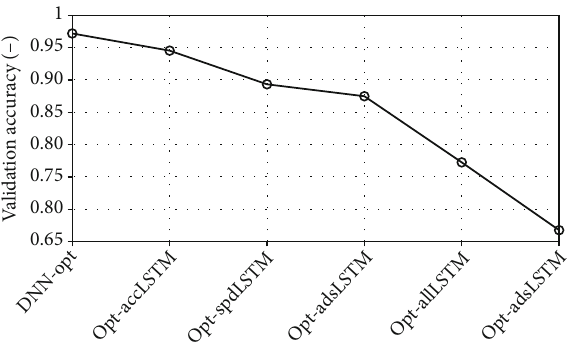
Figure 12: Ablation studies on DNN-opt. Speci fi cs of each ablated architecture are presented in Table 6. DNN-opt yields the best validation accuracy at